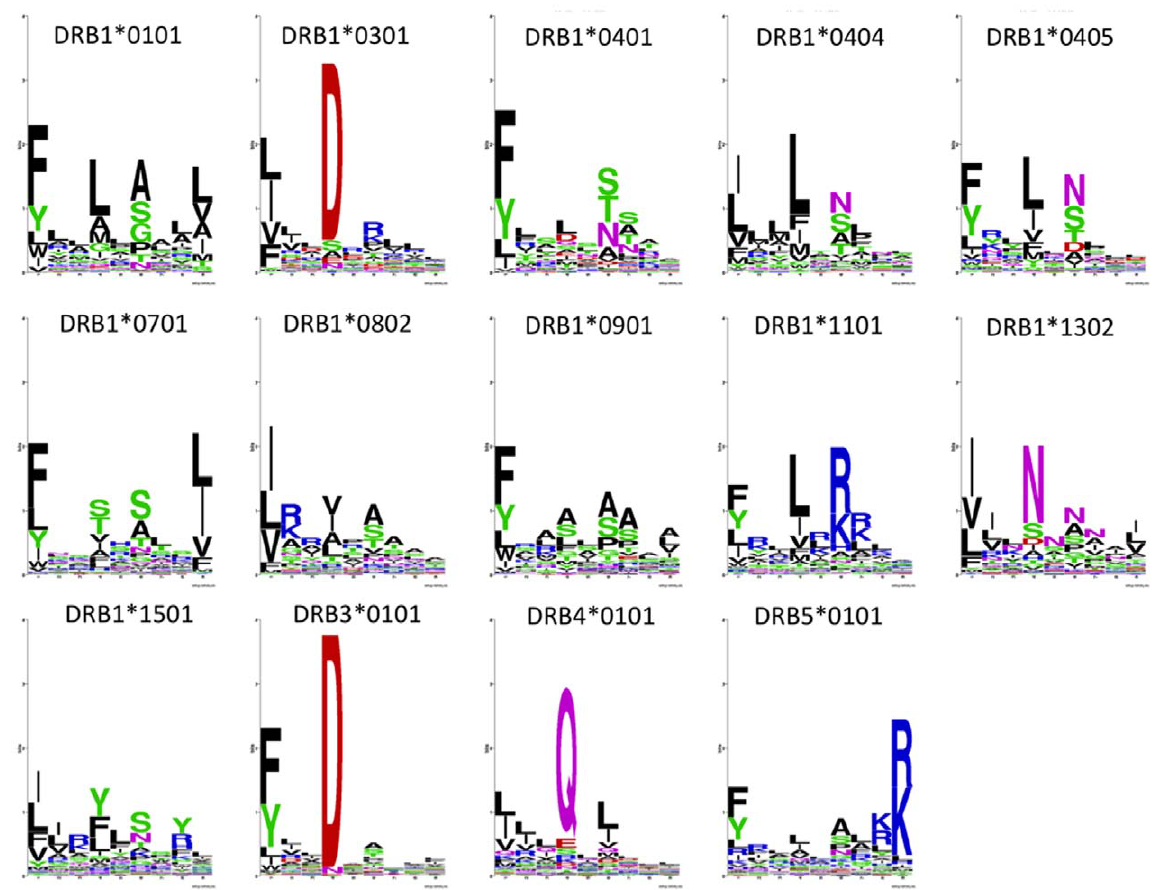
Figure 4. Sequence logo representation of the binding motifs for the 14 HLA-DR molecules contained in the Wang MHC class II data set. NNAlign was trained with Blosum encoding, including peptide length and flanking region length, PFRs of 3 amino acids, homology clustering at threshold 0.8 using all data points, 20 hidden neurons and a 5-fold cross-validation without stopping on the best test set performance.. Sequence logos are calculated as described in material and methods and visualized using the WebLogo program [48].